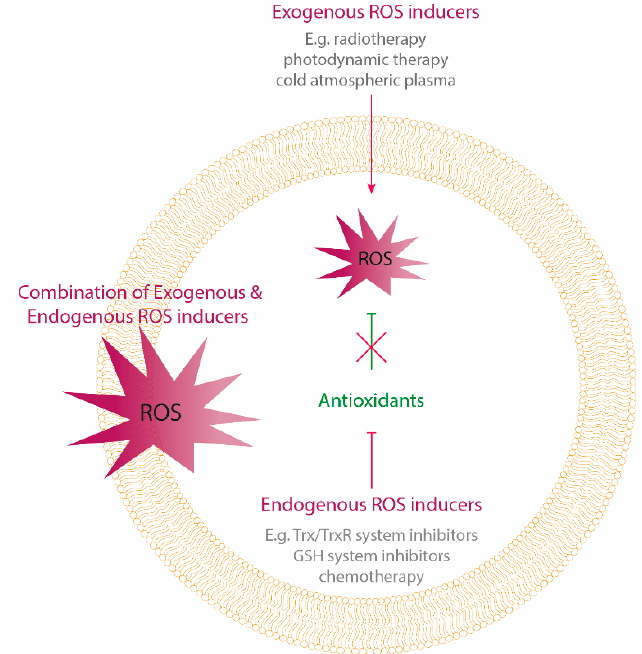
Figure 1. Oxidative stress-inducing treatment strategies. Oxidative stress can be induced by exogenous delivery of reactive oygen species (ROS) using physical treatment modalities, as well as by targeting the endogenous antioxidant system causing an intracellular accumulation of ROS. Cancer cells counteract exogenous delivery of high ROS levels by enhancing their antioxidant capacity. Therefore, a combination of both exogenous and endogenous ROS delivery by targeting the antioxidants, can be a promising anticancer strategy.